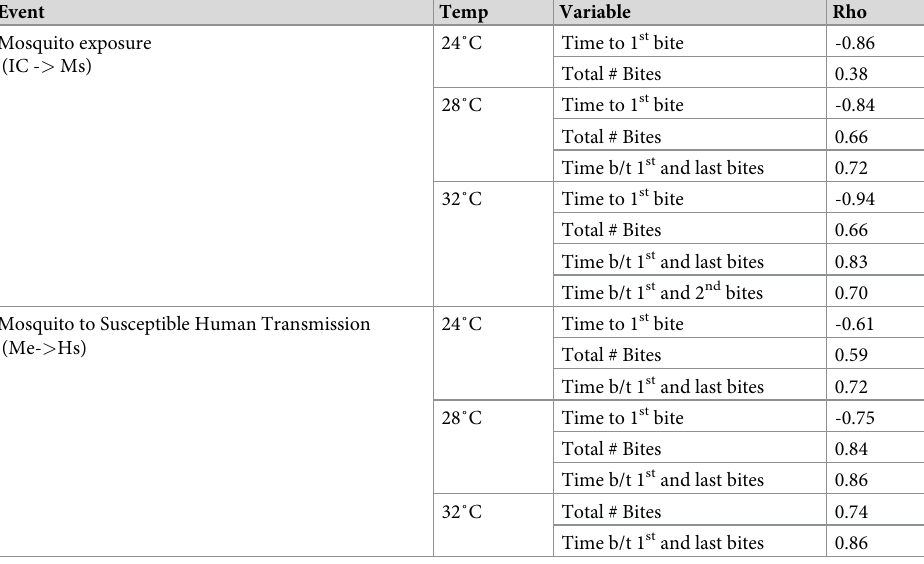
Table 3. The significantly correlated variables associated with successful exposure/ transmission demonstrate that factors associated with successful transmission are not uniform across all